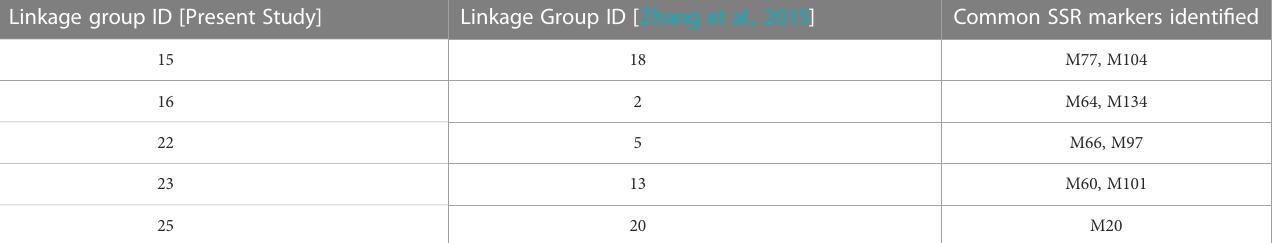
TABLE 3 Alignment of SSR-based linkage map with assembled pseudo-chromosomes of S.japonica.